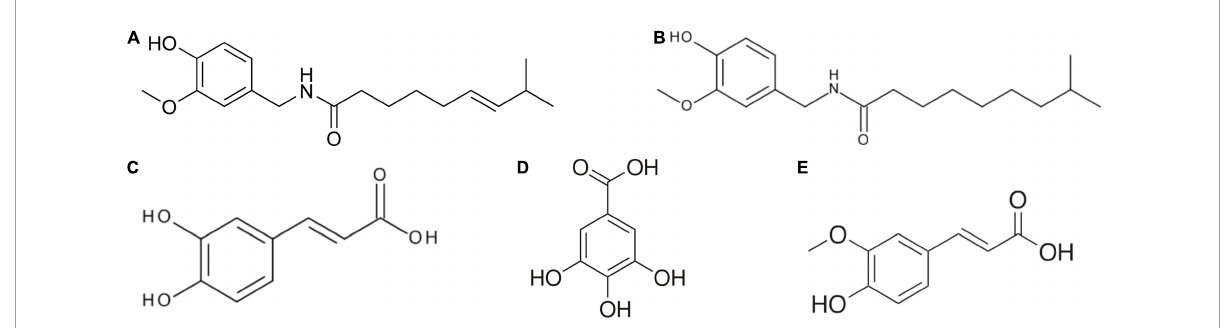
FIGURE1 Chemical structure of bioactive compounds found in chili pepper extracts: (A) capsaicin (CAP), (B) dihydrocapsaicin (DHC), (C) caffeic acid, (D) gallic acid, and (E) ferulic acid.